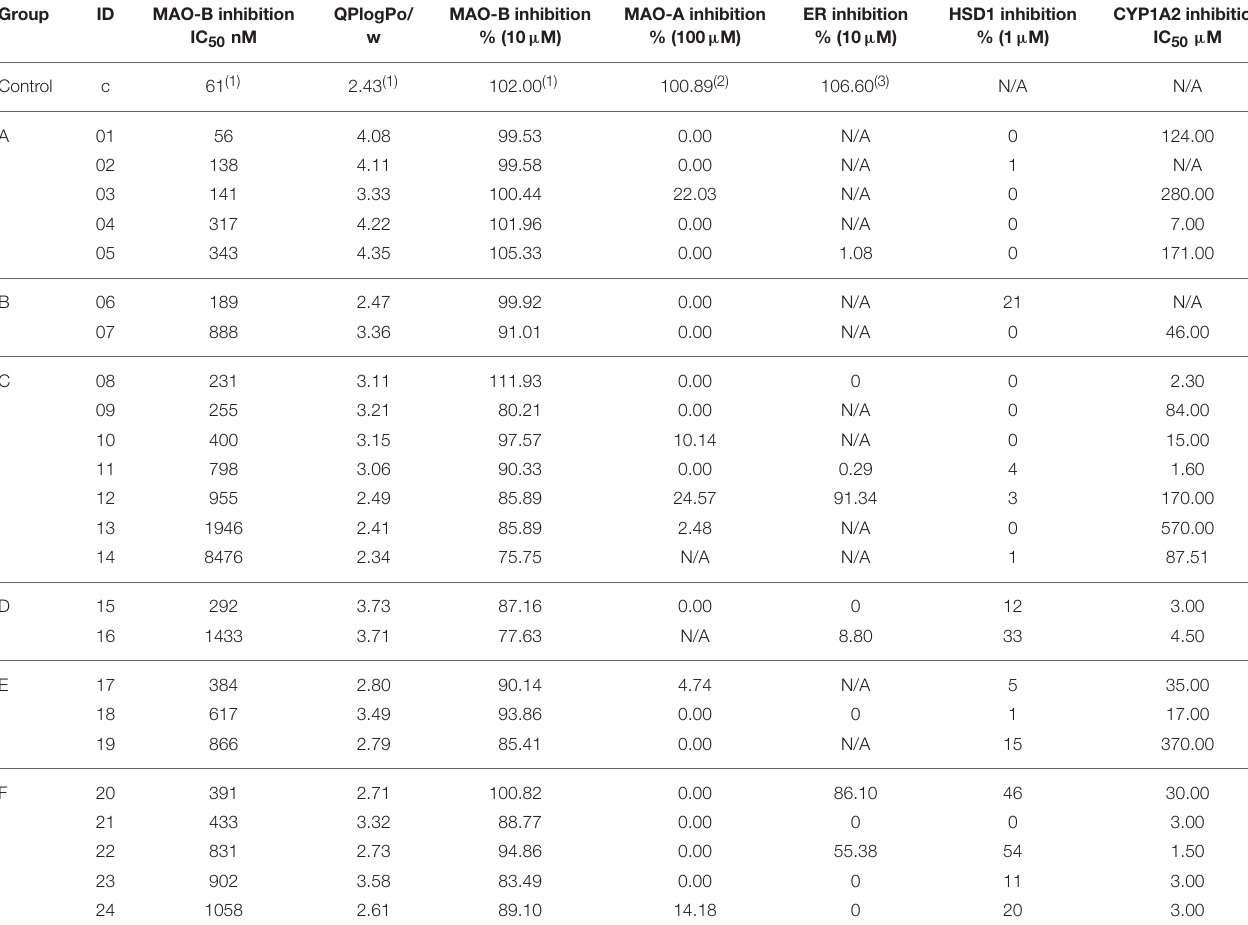
TABLE 1 | The activity data on the 24 most potent 3-phenylcoumarin derivatives. Group